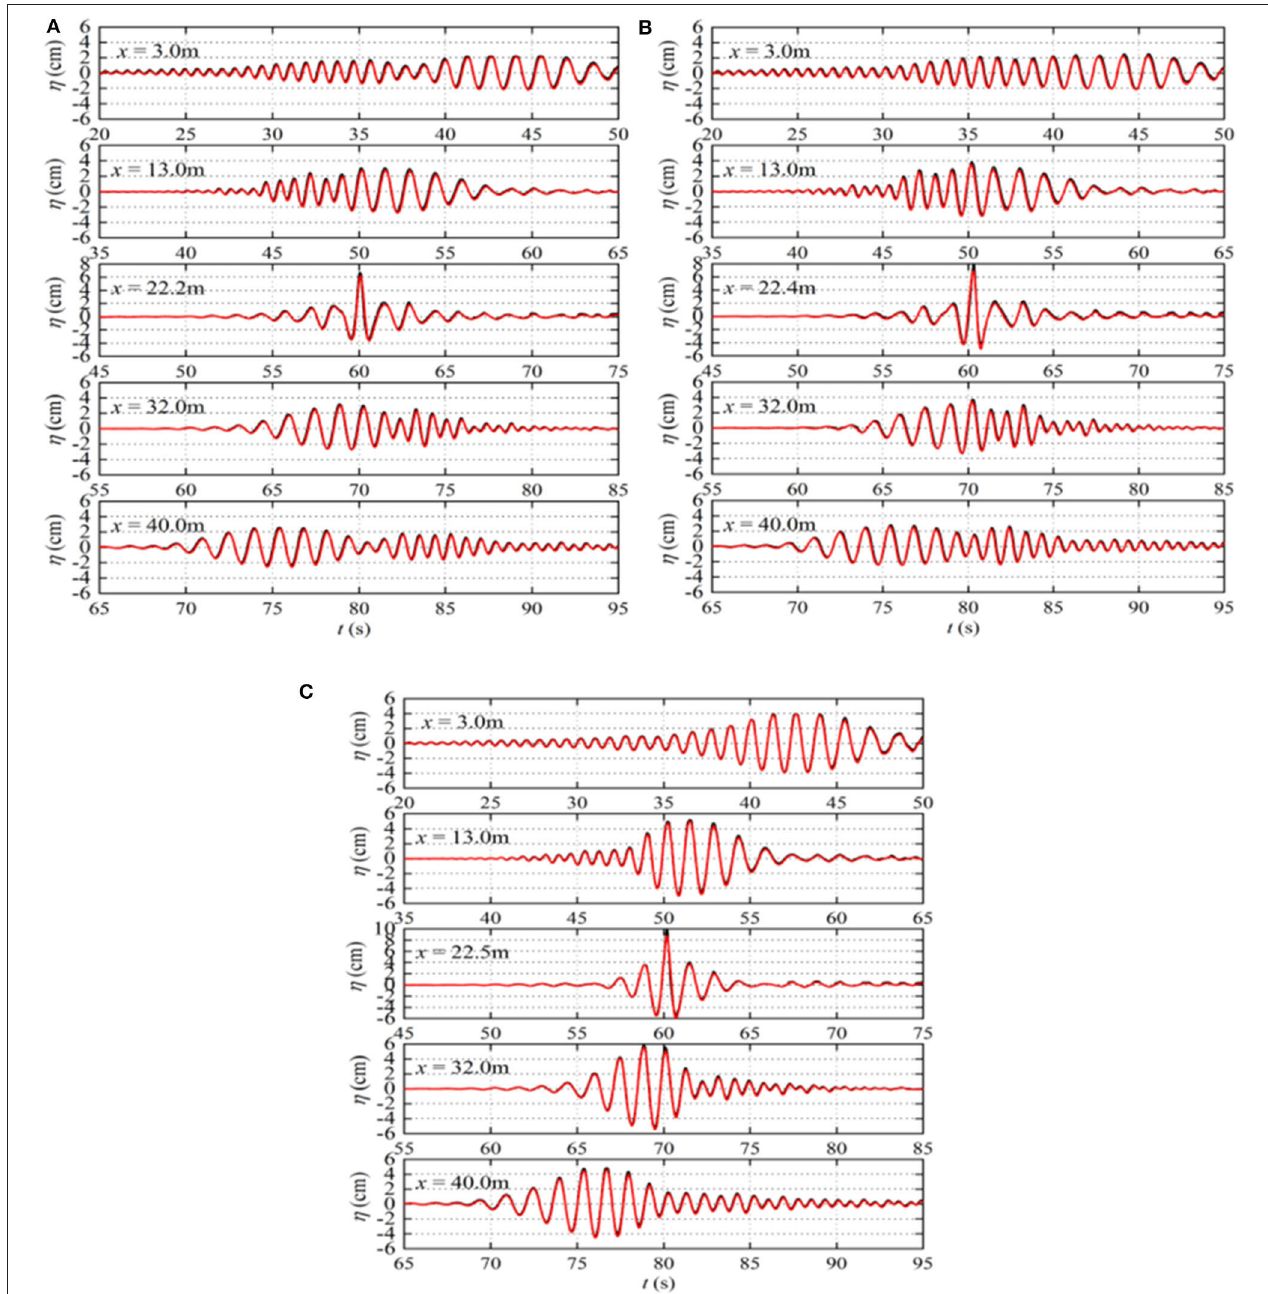
FIGURE 9 | The comparions of the free surface elevations between the focused double wave groups and the odd-order components of the focused double wave groups (black solid lines represent the focused double wave groups, and red solid lines represent the odd-order components of the focused double wave groups). (A) Case 1_AB, (B) Case 2_AB, (C) Case